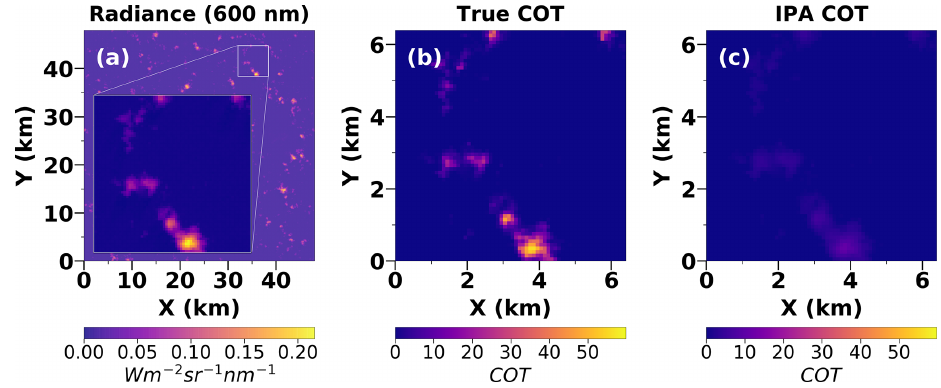
Figure 1. (a) Synthetic radiance field at 600nm generated with EaR 3 T using LES for a nadir view (30 ◦ solar zenith angle, 0 ◦ solar azimuth angle) that would be seen by a satellite imager at 705km. The inset shown is a 6.4km × 6.4km sub-domain region. (b) True COT (ground truth) for the sub-domain of 6.4km × 6.4km. (c) IPA retrieval for the sub-domain. The underestimation made by the IPA retrieval is visually